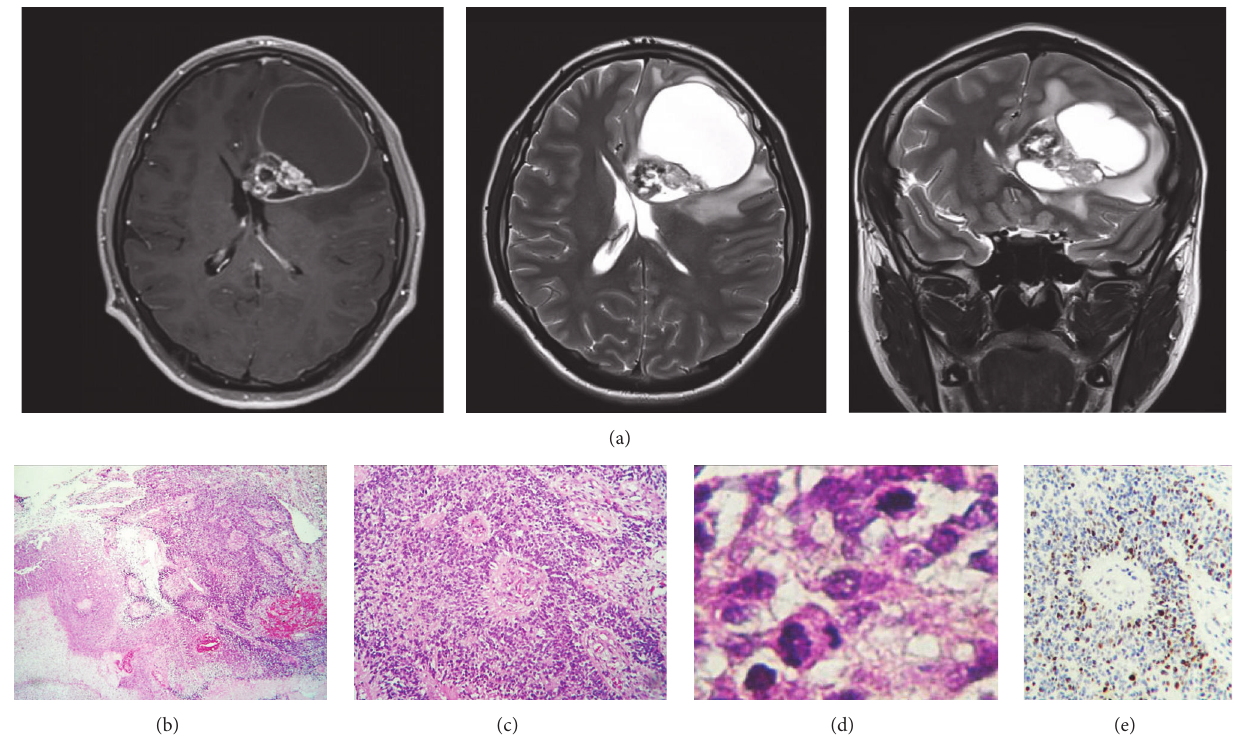
Figure 1: Magnetic resonance imaging scans/histopathological findings (anaplastic component). (a) Postcontrast T 1 (right), T 2 -weighted (center), and fluid attenuated inversion recovery, FLAIR, sequence (left) in axial and coronal planes demonstrating a left periventricular, partially cystic, and bulky tumour. (b) Panoramical low magnification photomicrograph showing a densely populated neoplasm apparently assembling rosettes (right upper field) and surrounded by geographic necrosis (left lower field). (c) High magnification photomicrograph of the right upper field shown in (b). There are multiple perivascular pseudorosettes denoting conspicuous microvascular proliferation. (d) Mitotic activity in a high-power field. (e) Ki-67 immunolabeling index ( ∼